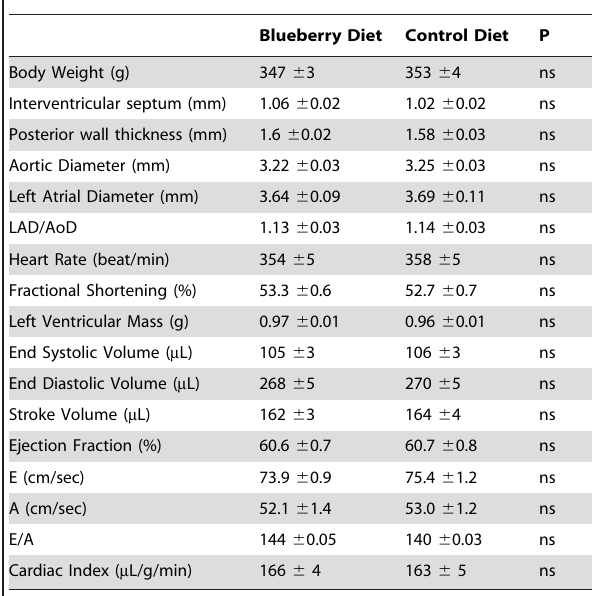
Table 1. Echocardiographic indices in rats after 3 months of control or blueberry-enriched